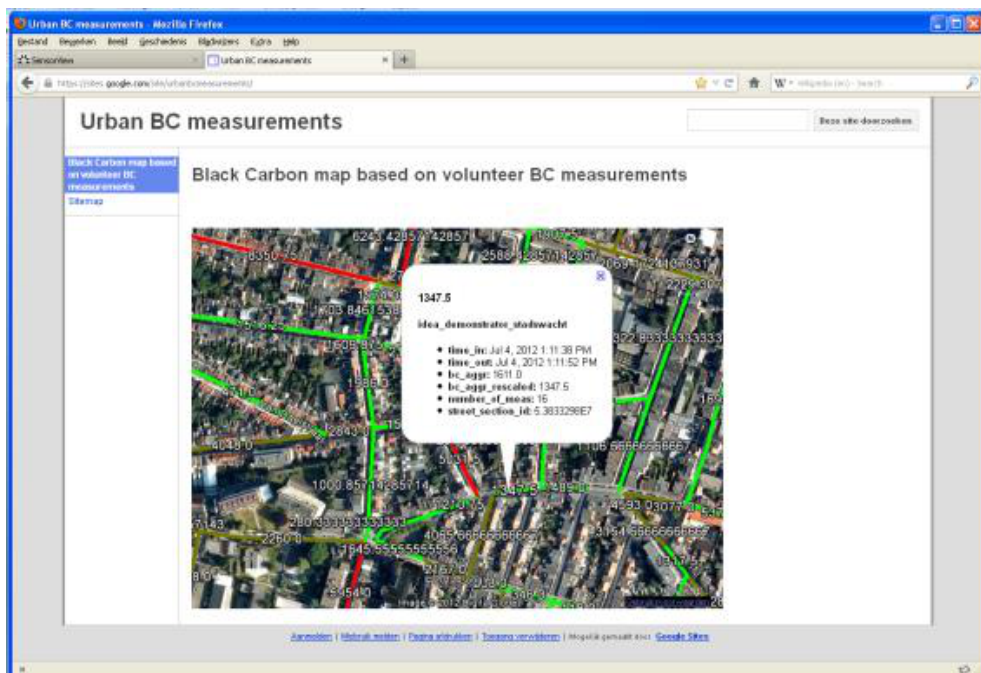
Figure 6. Automated, web-based black carbon map